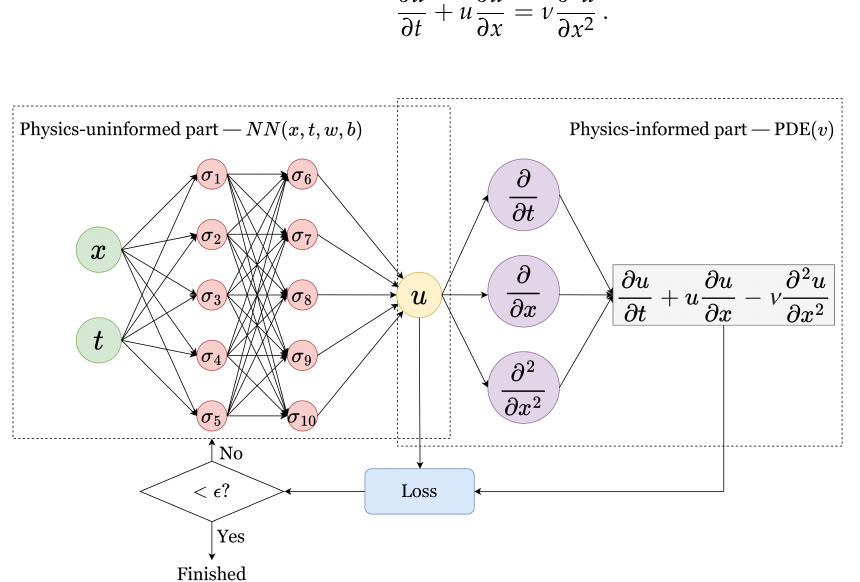
Figure 20. Schematic of PINN for solving forward problems with conventional (the left dotted box) and physics-informed (the right dotted box) neural networks with trainable weights w and biases b and a nonlinear activation function σ . PINNs integrate the measured and observed information with that produced using physical models by embedding the corresponding PDEs into the loss function of a neural network at a training stage. A set of sampled inputs ( x i , t i ) is passed through the network, then the Jacobian of the neural network’s output is computed with respect to these inputs, and finally, the residual of PDEs is computed and added as an extra term in the loss function. The network is trained by minimising the loss via a gradient-based optimisation method until it is smaller than a set threshold (cid:101)